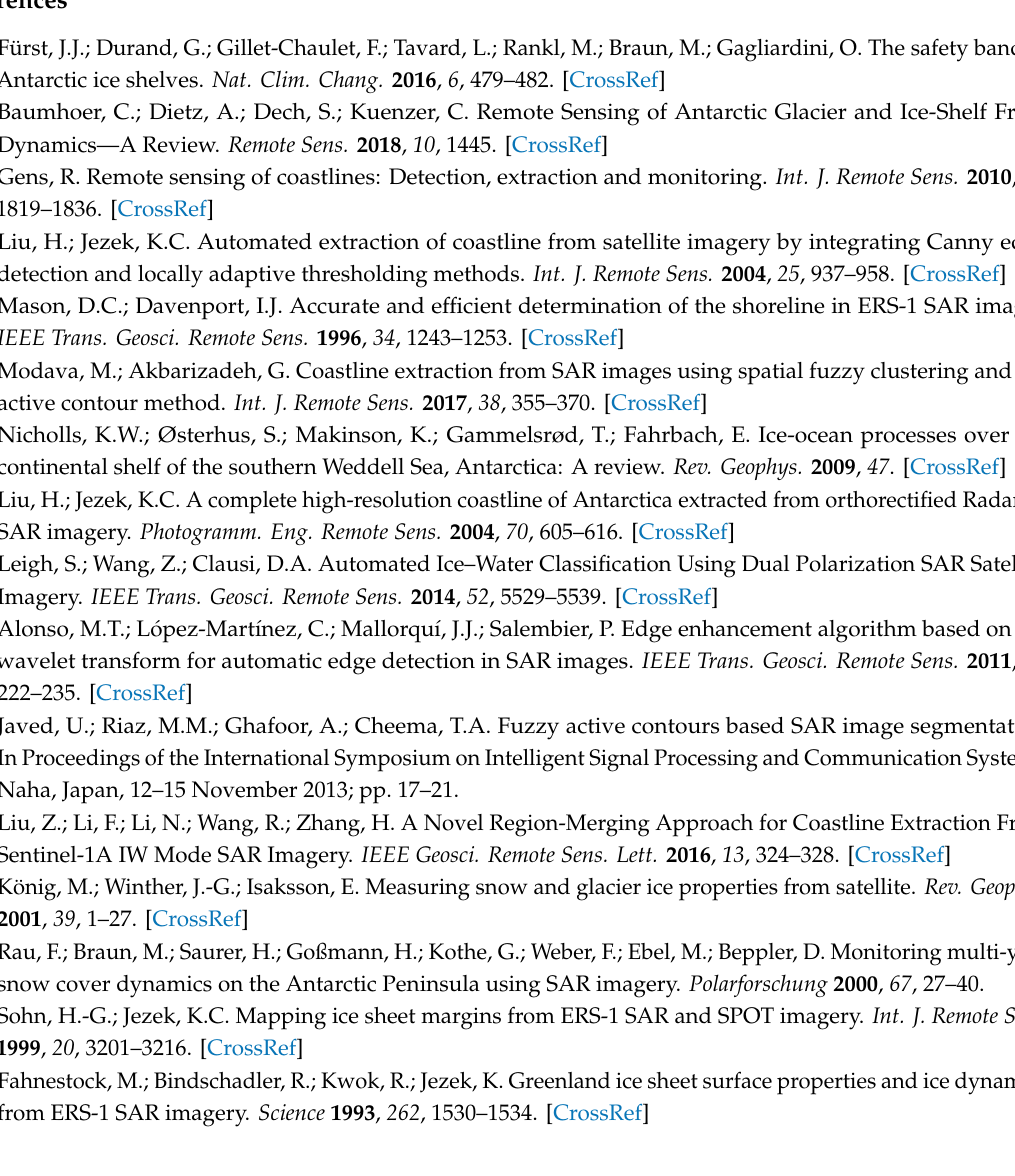
Table S1: List of Sentinel-1 scenes used for training and testing. Table S2: Scenes used to create the calving front time series for the Getz Ice Shelf. Figure S1: Comparison of the extracted coastline along Marie Byrd Land with a manual reference and the ADD coastline. Figure S2: Examples of fast ice